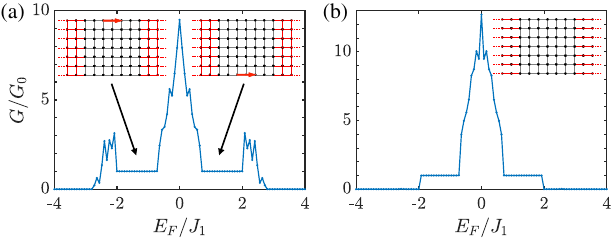
FIG. 4. Two-terminal conductance of the isotropic effective model in Eq. (7). Parameters are κ ¼ 0 . 01 ω =l H , J y ¼ J 1 , φ ¼ 2 π = 3 , λ 29 , N 30 . The sites in the reservoirs are y ¼ cut ¼ always horizontally coupled J r y ¼ J y , while vertical couplings in the reservoirs are (a) J r 1 ¼ J 1 , such that the wideband approxi- mation is valid, or (b) J r 1 ¼ 0 , for which the wideband approxi- mation breaks